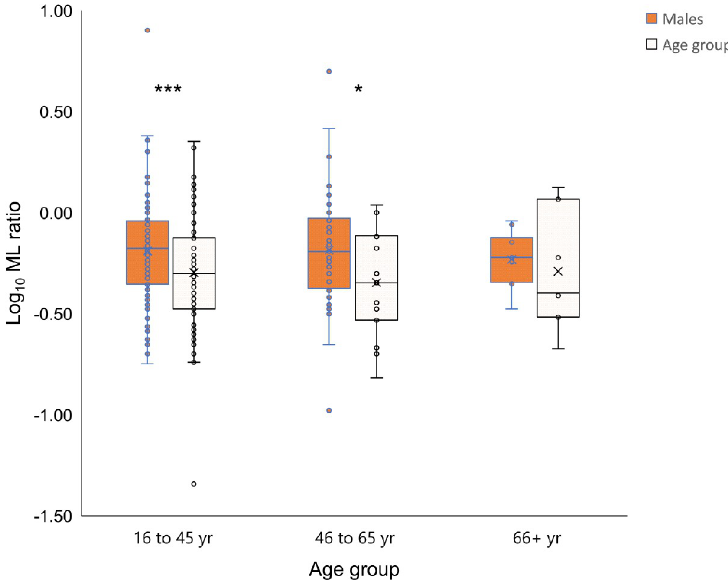
Fig 5. Age and sex differences in monocyte-to-lymphocyte ratios. MLRs were compared using log-transformed values by Student’s t-test. � P < 0.047 and ��� P < 0.0035. Mean ML values were 0.65 for males in the 16–45 and 46–65 age groups and 0.50 and 0.45 in females,